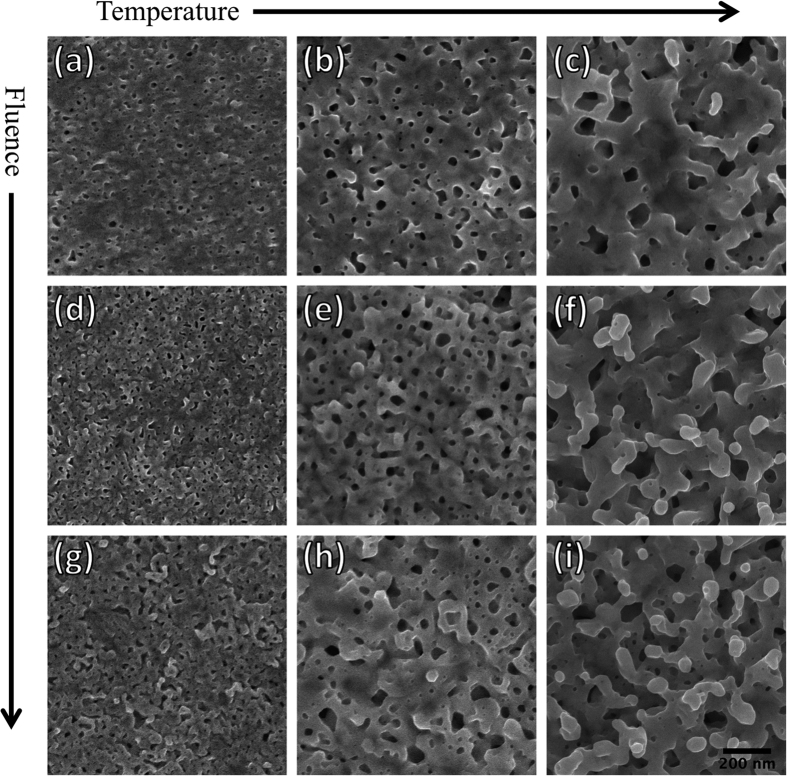
SEM micrographs of Ta samples irradiated with 100 eV He+ ions at various fluences and temperatures: (a–c) 4.3 × 1024 ions m−2 at 823, 1023, and 1223 K, respectively; (d–f) 8.6 × 1024 ions m−2 at 823, 1023, and 1223 K, respectively; (g–i) 1.7 × 1025 ions m−2 at 823, 1023, and 1223 K, respectively.